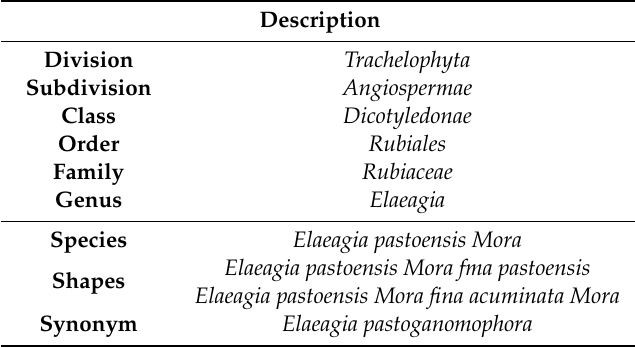
Table 1. Taxonomic classification of the Mopa-Mopa